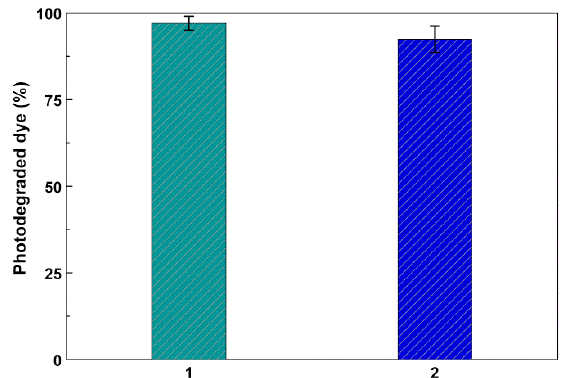
Figure 9. Percentage of degraded dye for Reactive Blue 250 in two cycles (1 and 2) of use of the photocatalyst. Error bars from three assays.